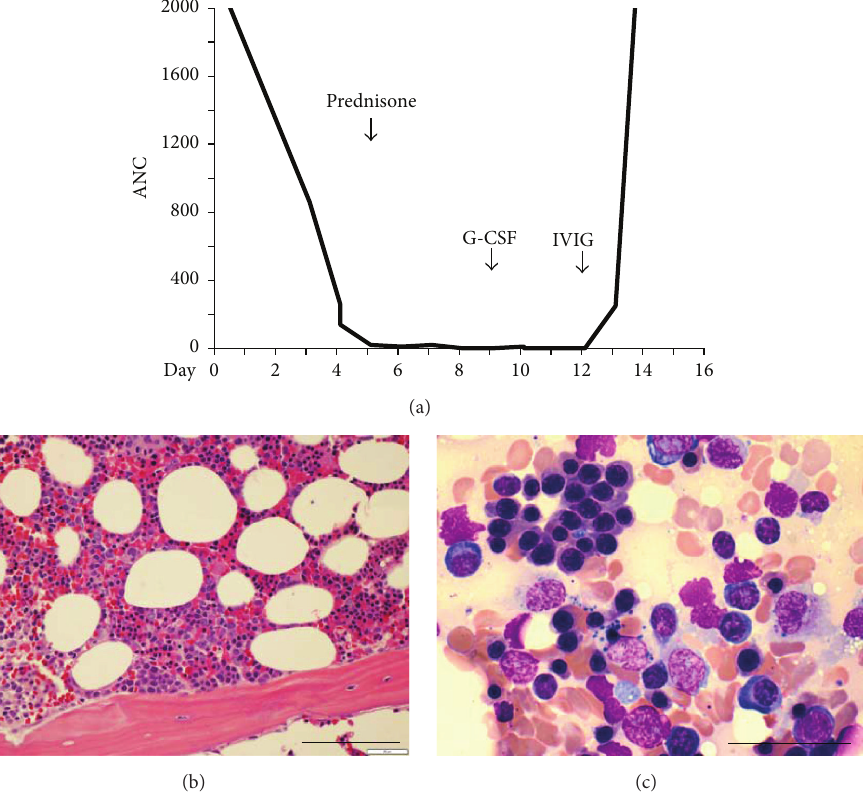
Figure 2: Agranulocytosis with normal erythropoiesis and megakaryopoiesis. (a) Time-course of ANC during the admission showing severe neutropenia despite initiation of prednisone. Recovery of ANC to levels > 2000 occurred after initiation of G-CSF and IVIG. (b) Bone marrow core biopsy showing paratrabecular region devoid of myeloid precursors but filled with erythroid precursors and occasional megakaryocytes. 400x. Scale bar 100 𝜇 m. (c) Bone marrow aspirate devoid of myeloid cells. 1000x. Scale bar 50 𝜇